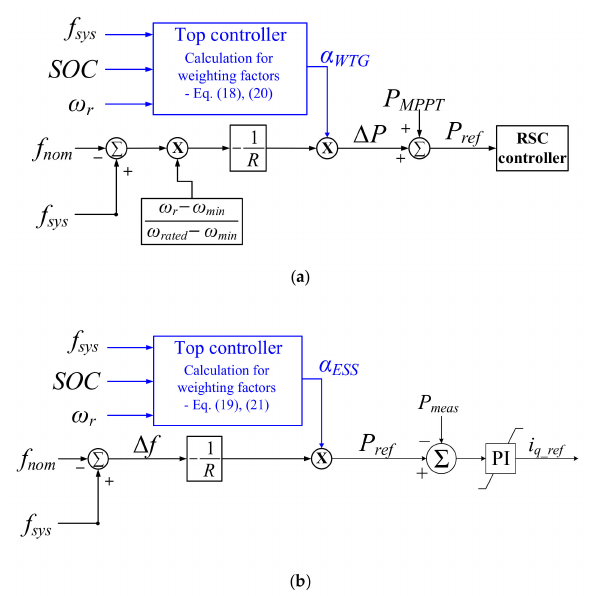
Figure 6. Operational characteristics of the proposed coordination control scheme. ( a ) Active power control of a WTG. ( b ) Active power control of an ESS.